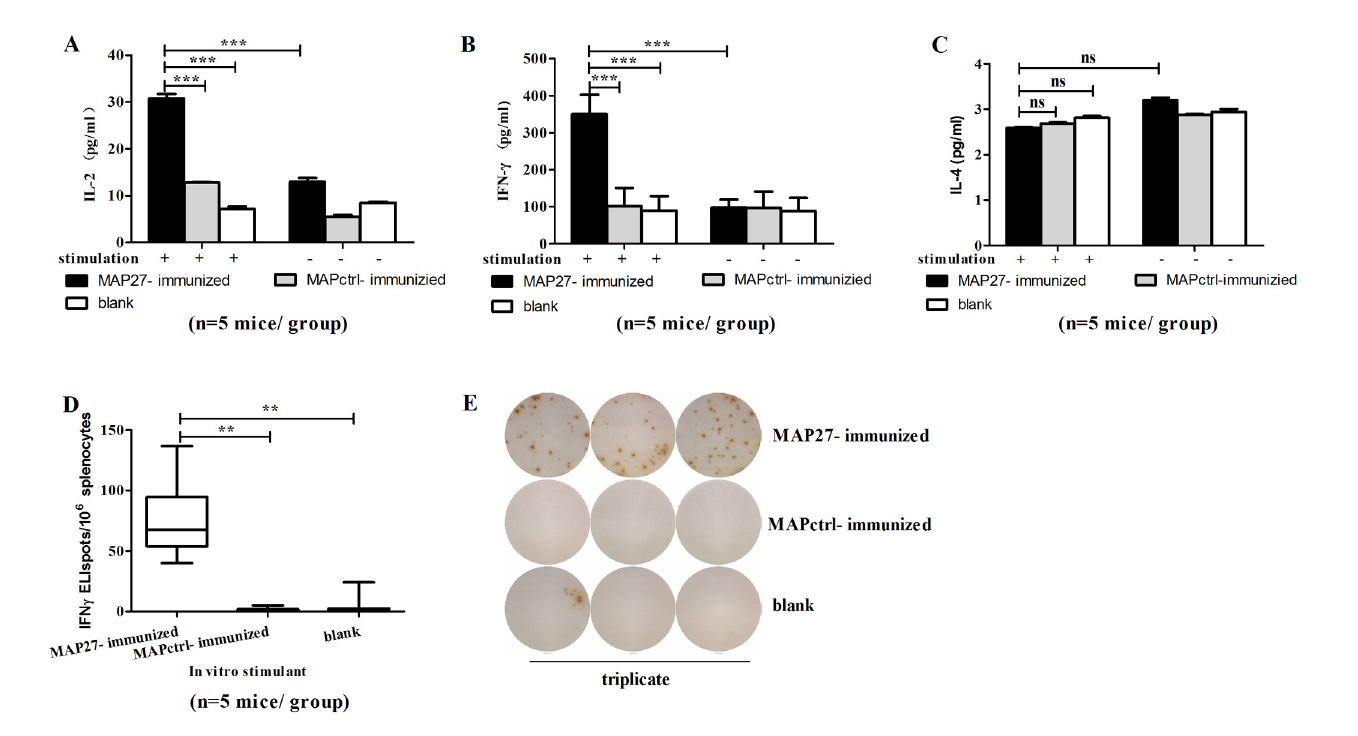
Fig 6. In vitro MAP27 treatment promoted the production of IFN- γ in splenocytes from MAP27-immunized mice. Five days after the last boost immunization, splenocytes isolated from the mice (n = 5 mice per group) were cultured at 2×10 5 /well in U-bottom 96-well plates and stimulated with MAP27 (100 μ g/ml) for 24 h. The concentrations of IL-2 (A), IFN- γ (B), and IL-4 (C) in supernatant were measured by ELISA. (D) Frequency of IFN- γ -producing cells induced by MAP27. Splenocytes isolated from the mice (n = 5 mice per group) were cultured at 4×10 5 /well in pre-coated plates, and stimulated with MAP27 (10 μ g/ml) plus anti-mouse CD28 antibody (1 μ g/ml) for 24 h. The number of IFN- γ -producing cells was then measured by ELISPOT and shown in box and whisker plots. (E) Representation of one of the ELISPOT assays. ** P < 0.01; *** P < 0.001; ns: P > 0.05.